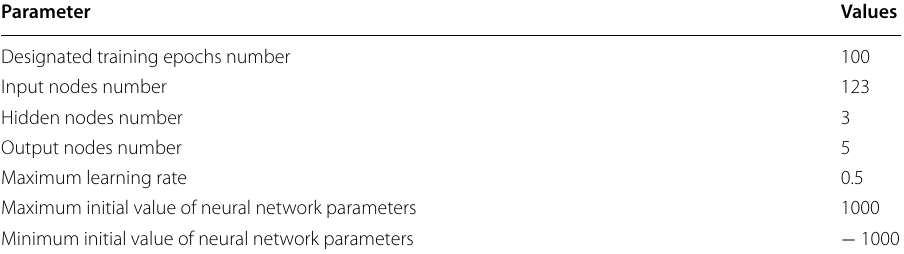
Table 3 Configuration of MBPNN